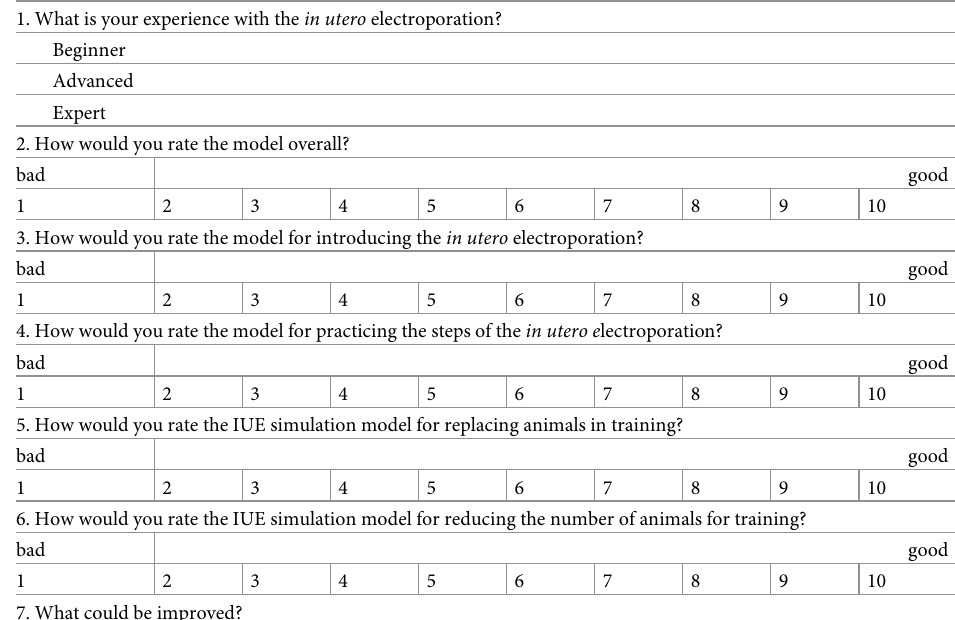
mechanical properties of each body tissue complicate replication. For example, much of the weight and softness of the brain consists of water, which varies according to the region of the brain, an explicit limitation for current 3D printers and materials (e.g., hydrogels and sili- cones) when used in small animal anatomies such as mouse brains [35]. Silicone hardness also